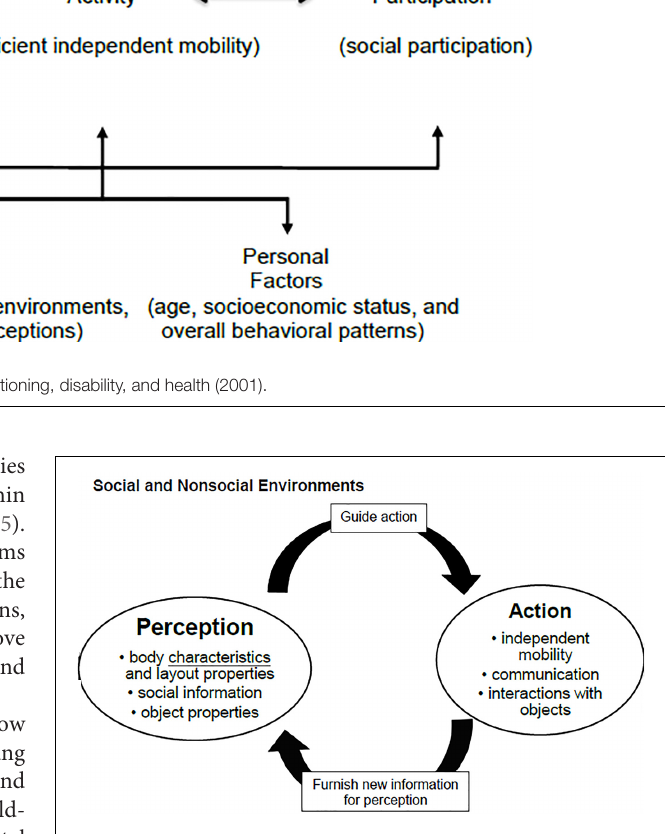
FIGURE 2 | Perception-action coupling and environment. On the basis of Gibson’s ecological approach to perceptual learning and development (Gibson and Pick,